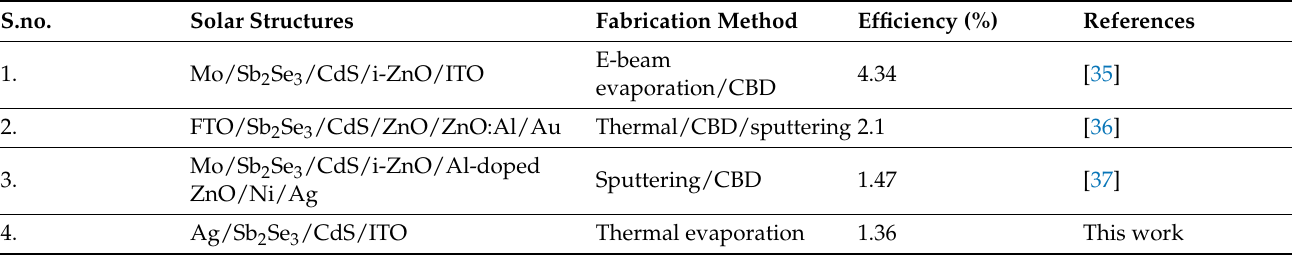
Table 3. Comparison of Sb 2 Se 3 -/CdS-based solar cells fabricated by various